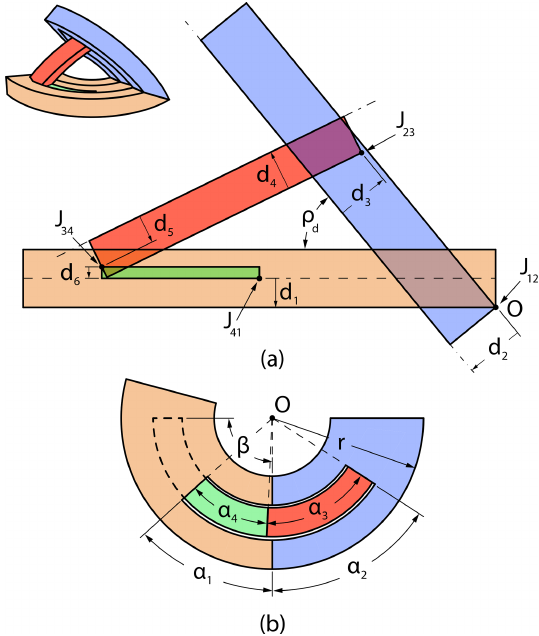
Figure 5. General diagram for a spherical deploying strut ThUDS with key parameters shown. Showing (a) the projection of the outer surface (isometric view) in the deployed state and (b) the flat state from above. Dashed lines in (b) show the position of link 4 in the deployed state. Joints rotate about O .